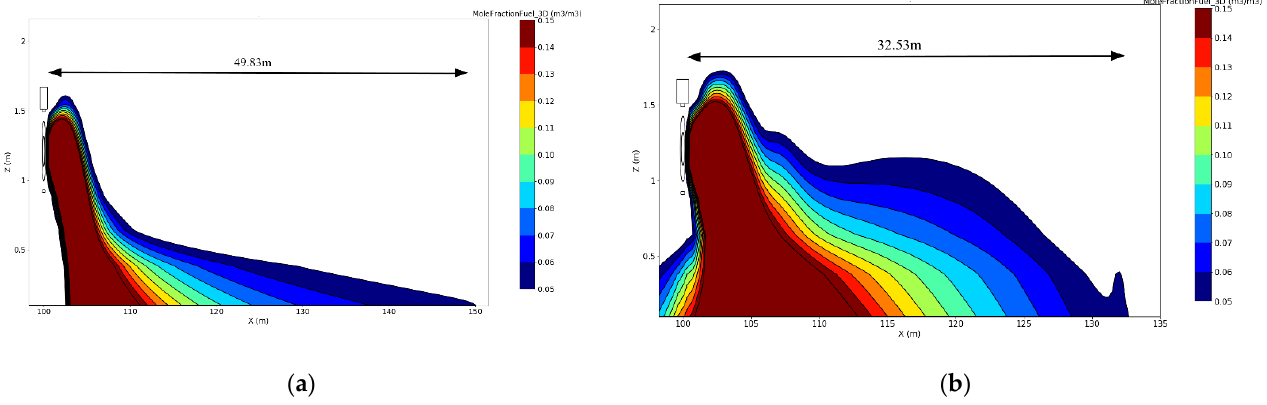
Figure 6. ( a ) Section view of the tailwind leak showing LFL distance of 49.83 m; ( b ) section view of the headwind leak showing LFL distance of 32.53 m.